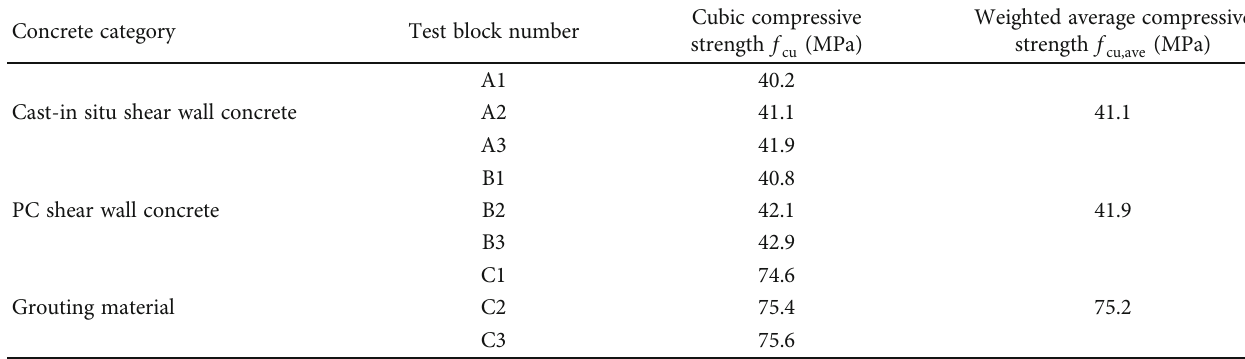
Table 1: Measurements of mechanical properties of concrete.